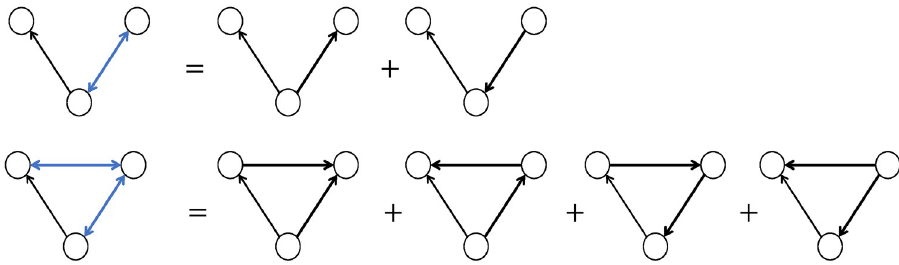
Fig 3. Dealing with bidirectional edges. First row shows that an open triad with one bidirectional edge is counted as two unidirectional open triads; second row shows that a triangle with two bidirectional edges is counted as four unidirectional